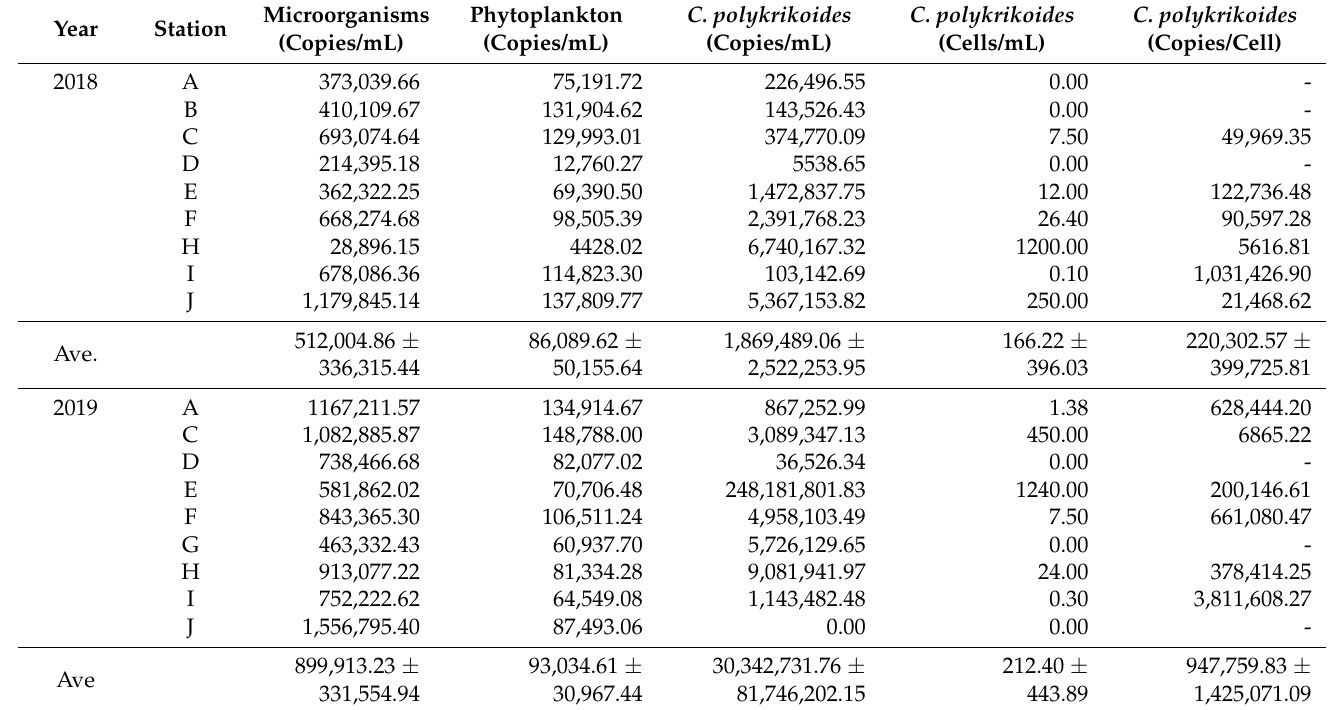
Table 3. Copy numbers of C. polykrikoides and microorganisms and phytoplankton according to quantitative